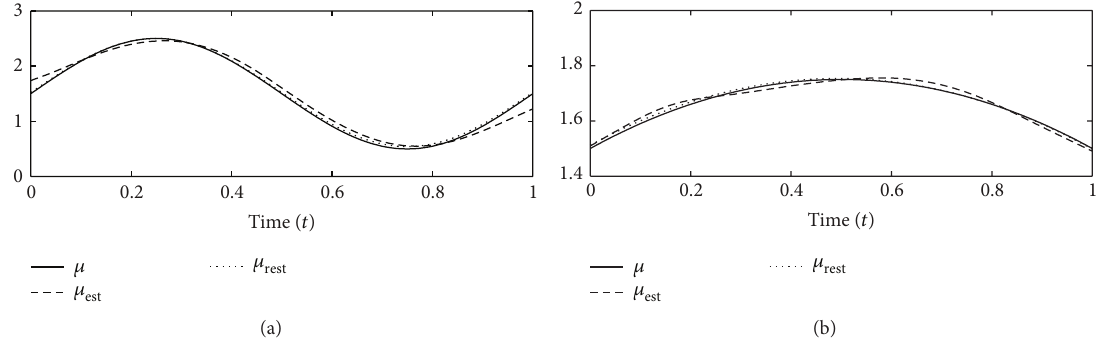
Figure 4: Comparison of dynamic behavior of 𝜇(𝑡) , 𝜇 est (𝑡) , and 𝜇 rest (𝑡) . In case (a) 𝜇 1 (𝑡) = 1.5+ sin (2𝜋𝑡) and in case (b) 𝜇 2 (𝑡) = −0.5𝑡 2 +𝑡+1.5 .